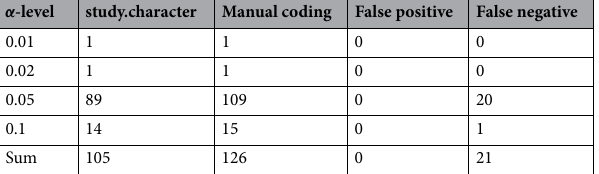
Table 4. Absolute frequencies of detected α -level from 1- α confidence